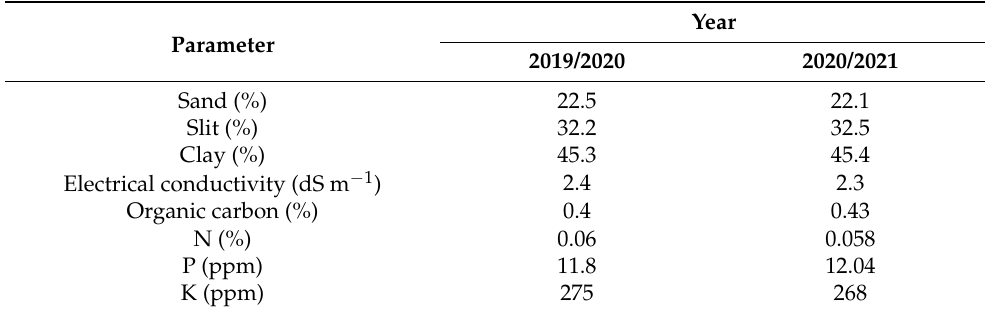
Table 1. Experimental field soil properties across the two experimental years (2019/2020 and